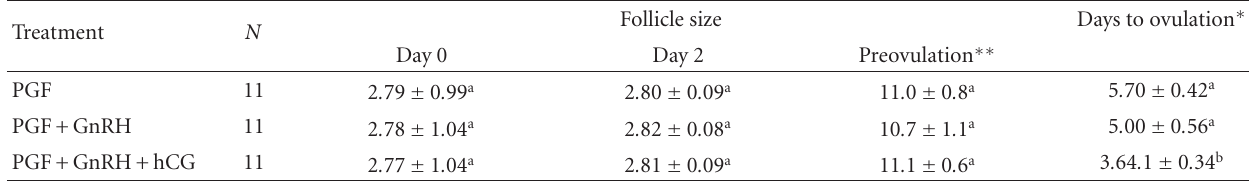
Table 1: Means and standard errors for size (mm) of ovulating follicle and days to ovulation.